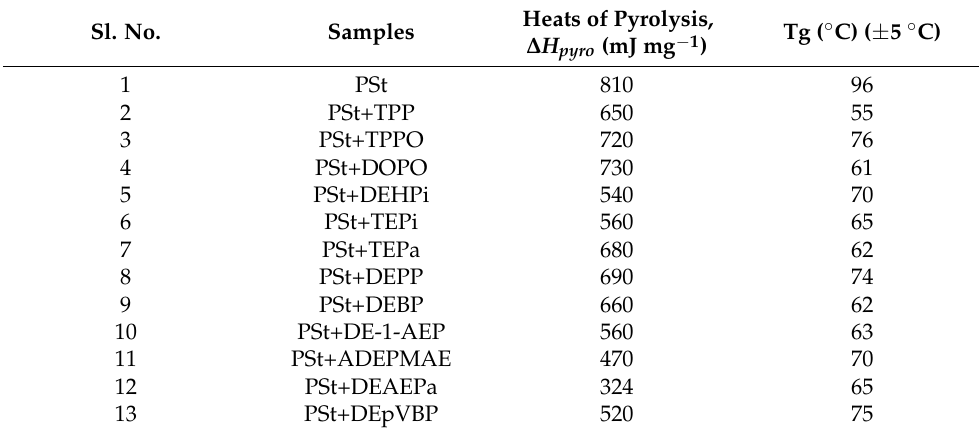
Table 4. Heats of pyrolysis data of PSt-based materials obtained from DSC tests. Sl. No.